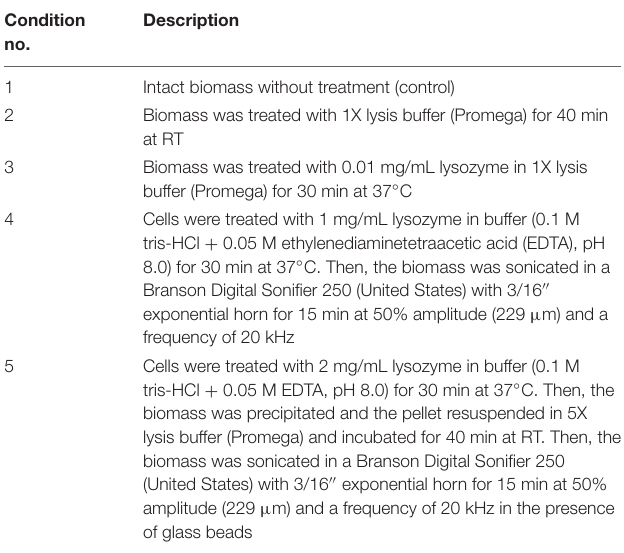
TABLE 2 | Complementary biofilm extraction conditions tested (by order of harshness increment). Condition